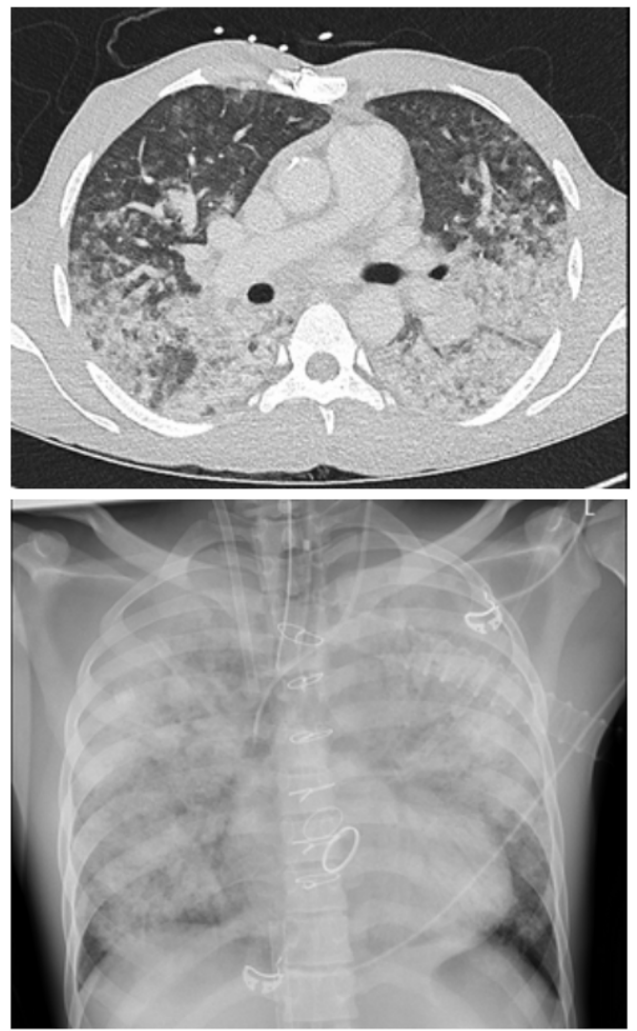
Figure 1. CT and Chest-X ray with bilateral diffuse alveolar opacification. Table 1. Case characteristics of previous Q-fever endocarditis Patient Diagnosis / Infected valve (Q - Fe-